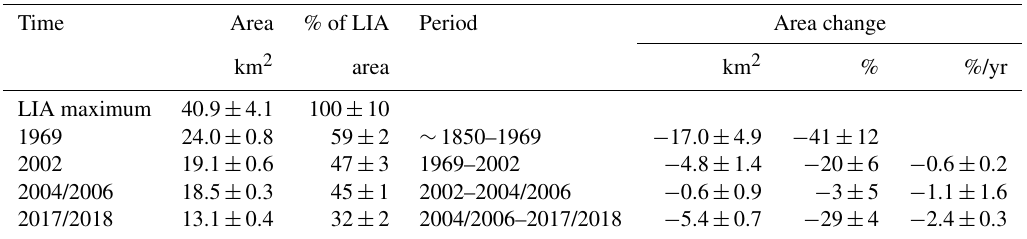
Figure 8. Summary of the workflow for high-resolution glacier mapping and mass balance calculation for the period t 1 to t 2 as applied in this study. The workflow does lead to quantitative results for most of the glaciers but also shows the need of scientific discussion on geomorphological processes other than ice melt contributing significantly to volume changes. See Fig. 7 for the colour table of the volume change maps displayed (photos: Andrea Fischer; geodata: source Land Tirol). Table 3. Glacier area in the Austrian part of the Silvretta between LIA maximum, 1969, 2002, 2004/2006, and 2017/2018. For Vorarlberg, lidar flights were carried out in 2004 and 2017 and for Tyrol in 2006 and